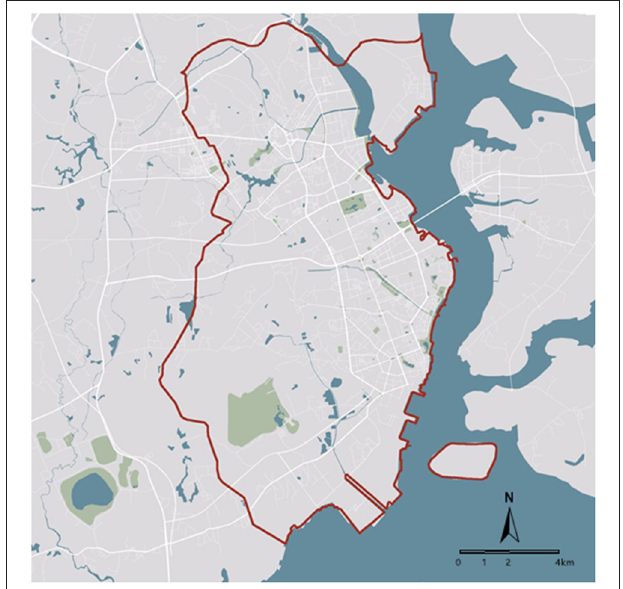
FIGURE 1 | Research sites: Chikan District and Danxia District, two urban areas in